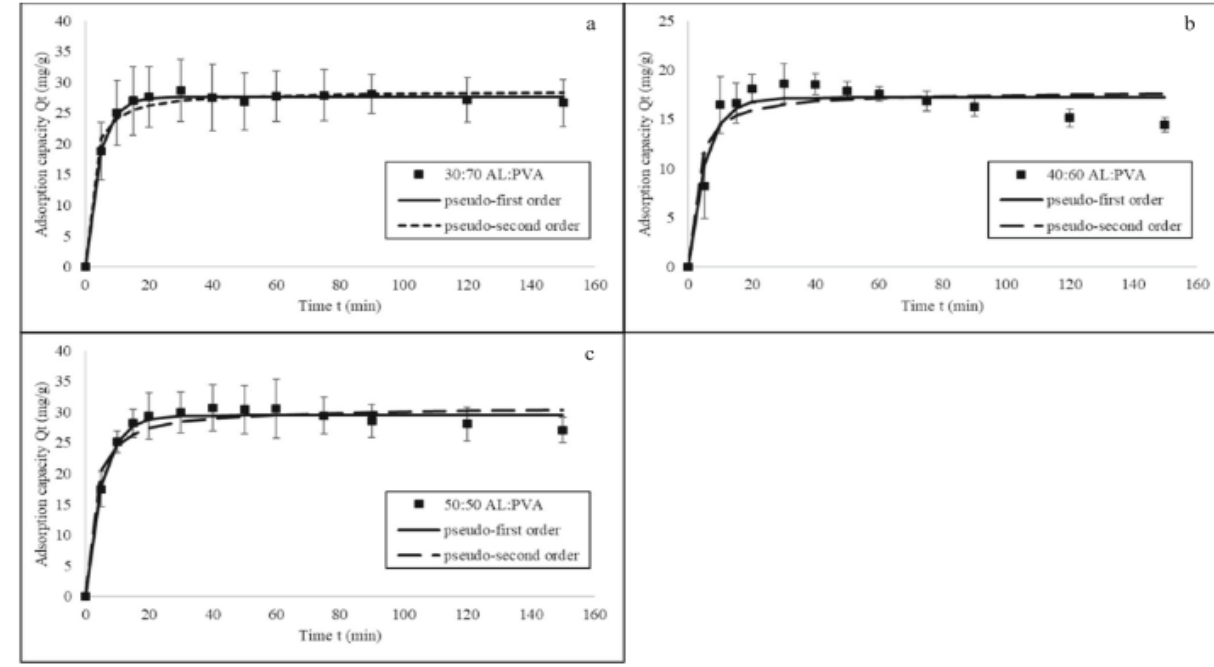
Figure 9. Adsorption capacity through time of AL:PVA nanofibers for FLX with three different ra- tios: ( a ) 30:70, ( b ) 40:60, and ( c ) 50:50 adapted with permission from